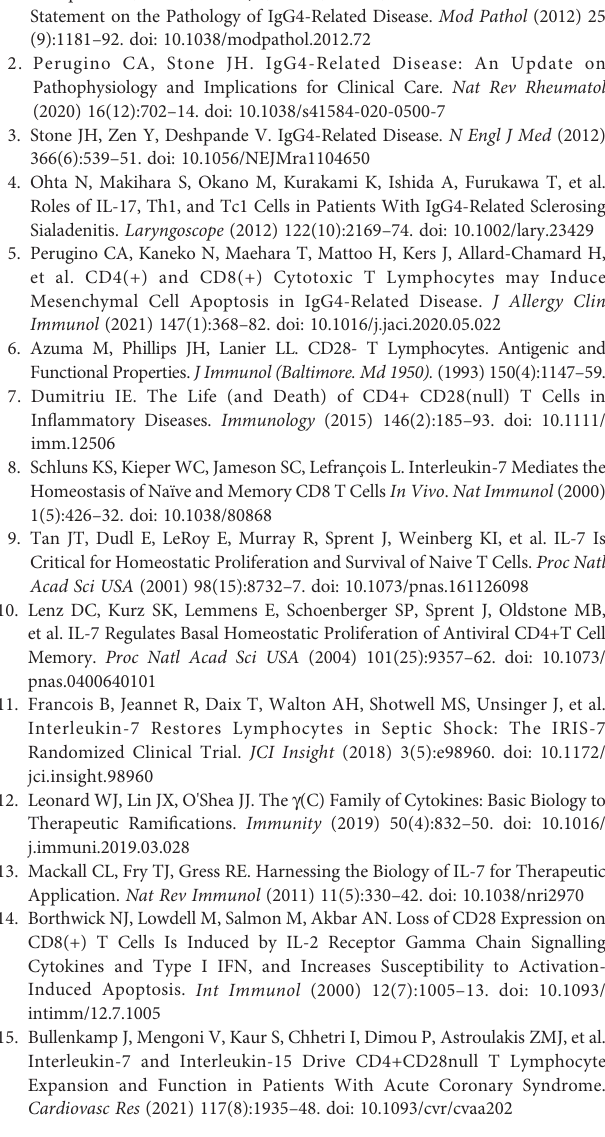
Supplementary Figure 1 | The correlations of circulating CD4+CD28- CTL levels with IgG4-RD RI, serum IgG4 and IgE concentrations in IgG4-RD patients. Correlation analyses were conducted between the levels of CD4+CD28- CTLs and IgG4-RDRI (A,D) ortheconcentrationsofserumIgG4 (B,E) andIgE (C,F) inIgG4- RD patients (n = 50). Each plot represented the data of one patient. The Spearman test ’ s correlation coef fi cient r and P values were listed, and the P values less than 0.05 were linearly regressed to show relevant trends. Supplementary Figure 2 | The correlations of circulating CD8+CD28- CTL levels with IgG4-RD RI, serum IgG4 and IgE concentrations in IgG4-RD patients. Correlation analyses were conducted between the levels of CD8+CD28- CTLs and IgG4-RDRI (A,D) ortheconcentrationsofserumIgG4 (B,E) andIgE (C,F) inIgG4-